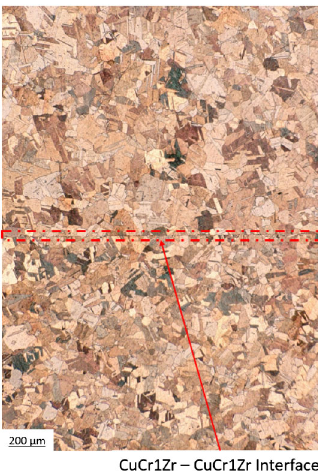
FIG. 10. Optical microscopy of a sample containing the HIP diffusion bonded CuCr1Zr-CuCr1Zr interface. The surface in- spected has been mechanically polished and chemically etched.